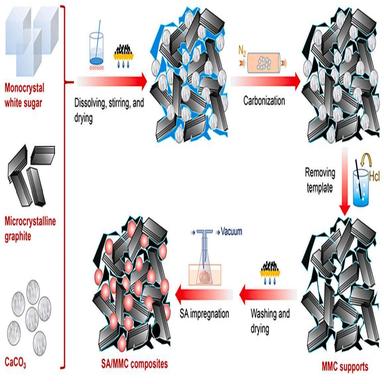
Schematic of preparation process of composite PCM.